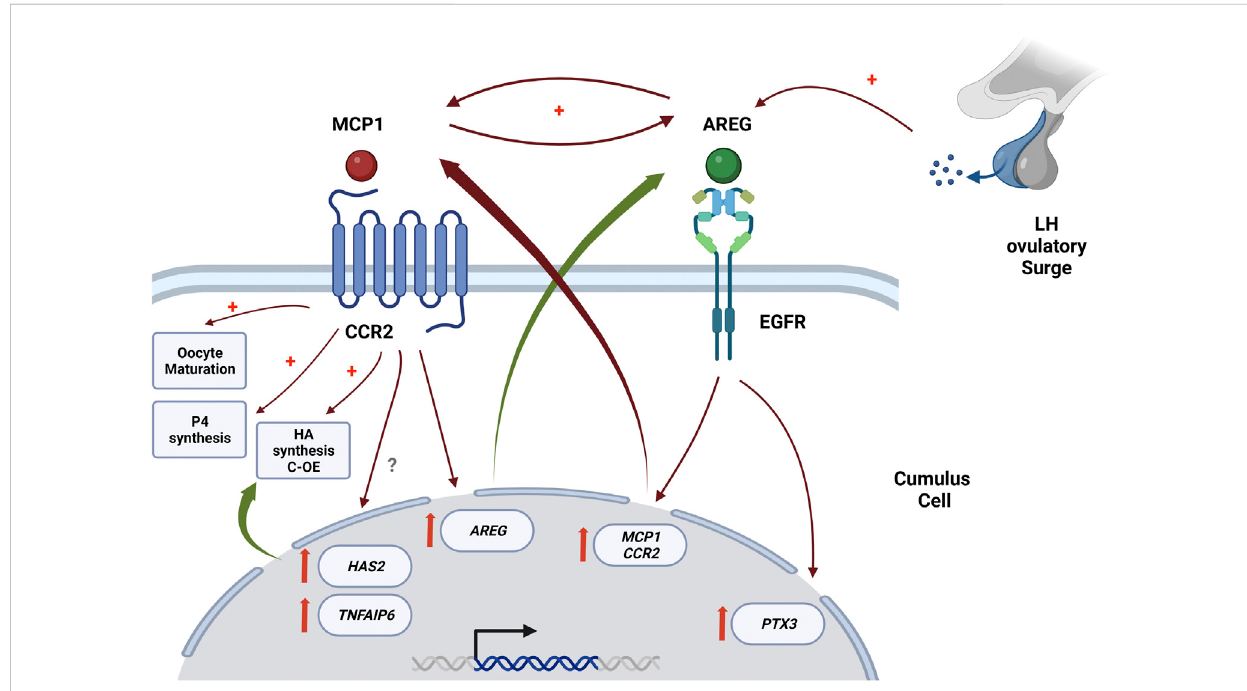
FIGURE 6 Proposed interaction between CCR2 and EGFR pathways in the C-OE process and oocyte maturation, with CCR2/MCP1 signaling pathway being downstream of the EGFR in the ovulatory cascade. This scheme is proposed based on mainly our current results in conjunction with some of our previously published results (Rojo et al., 2019; Jaworski et al., 2020). This fi gure was creating in